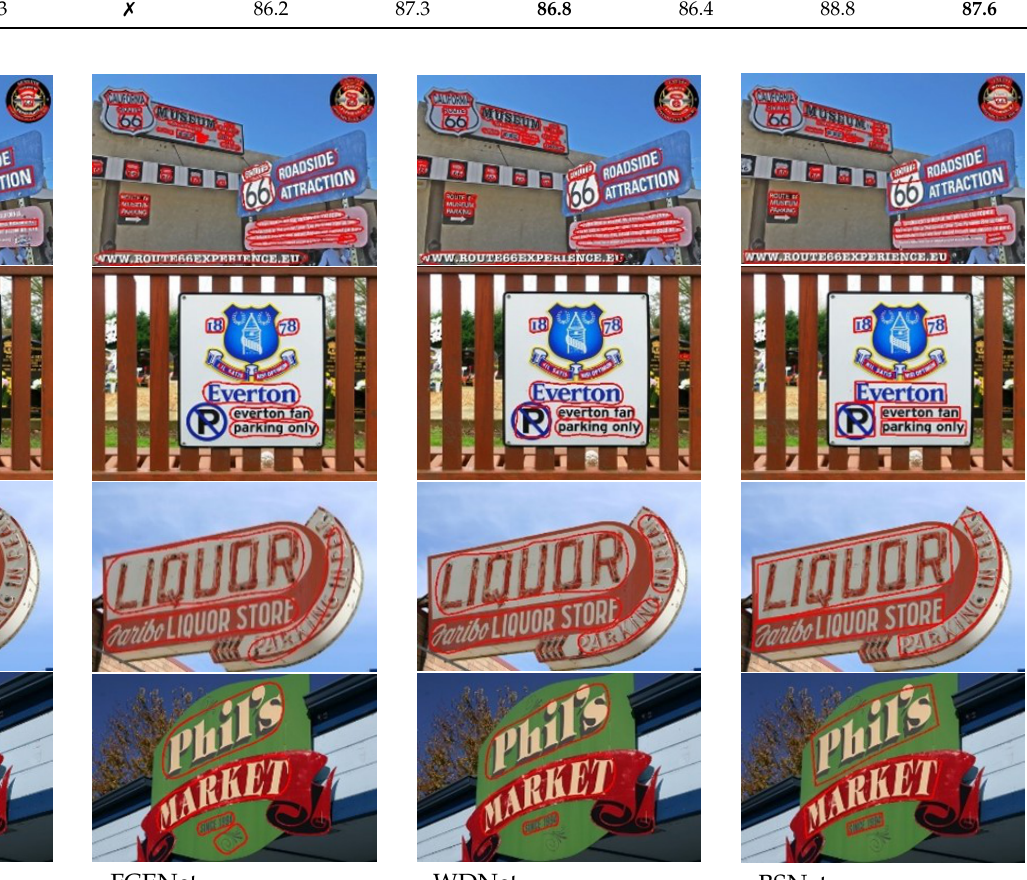
Figure 5. Performance comparison of the proposed model with ABCNet, FCENet, and